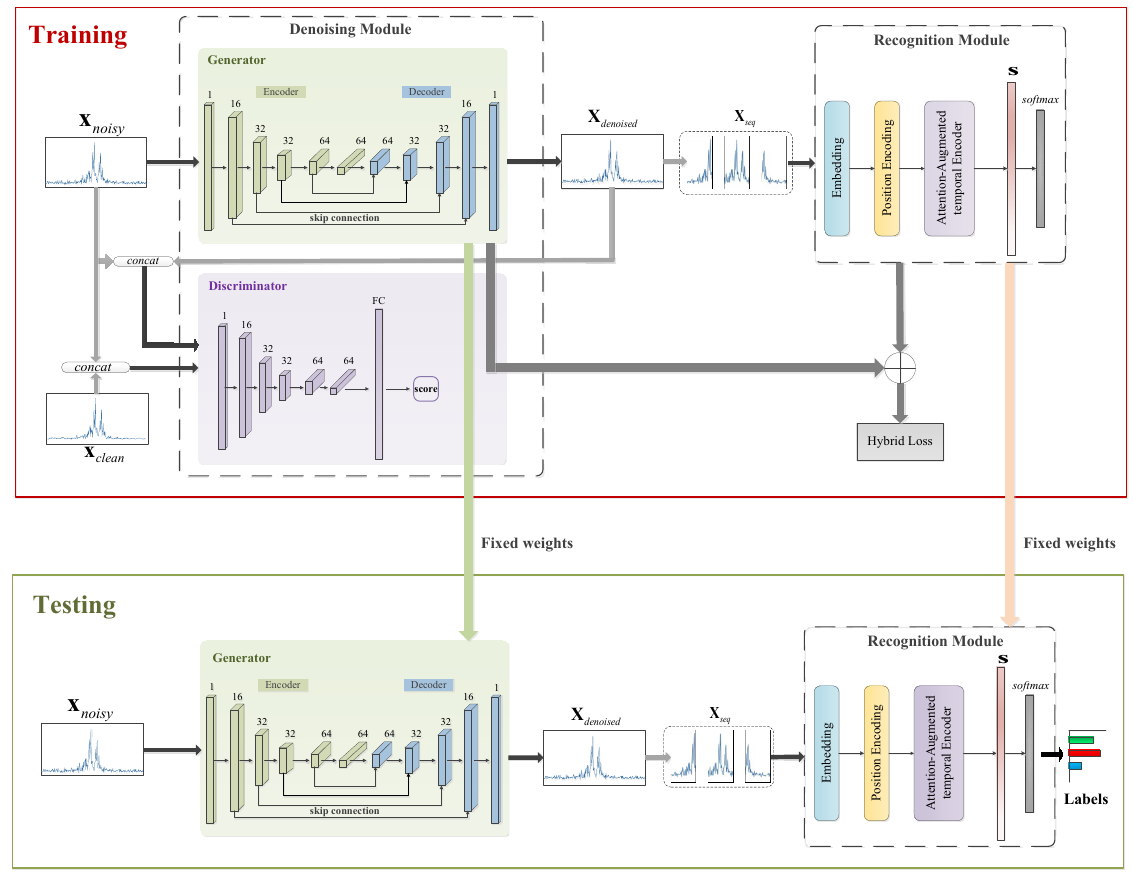
Figure 2. The framework of the IDR-Net.